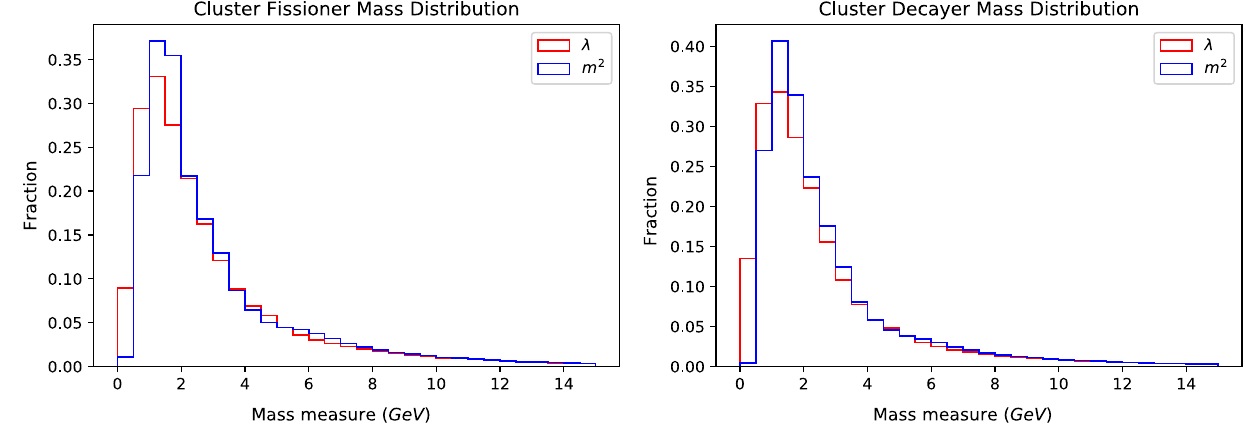
Fig. 8 Comparison of the two different mass measures for the cluster fission and cluster decayer stages respectively for LEP events at 91.2 GeV